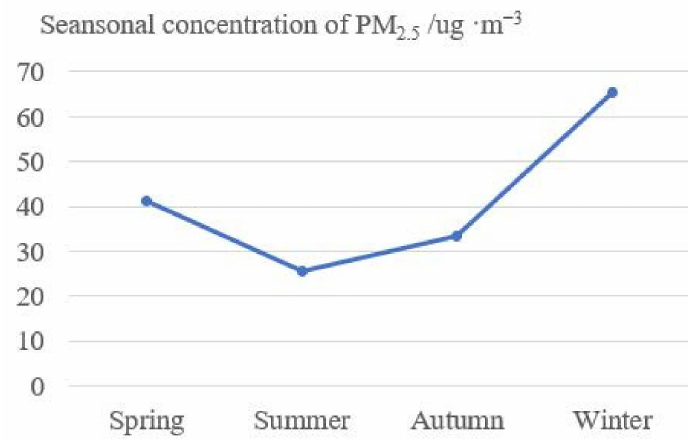
Figure 4. Seasonal variation of PM 2.5